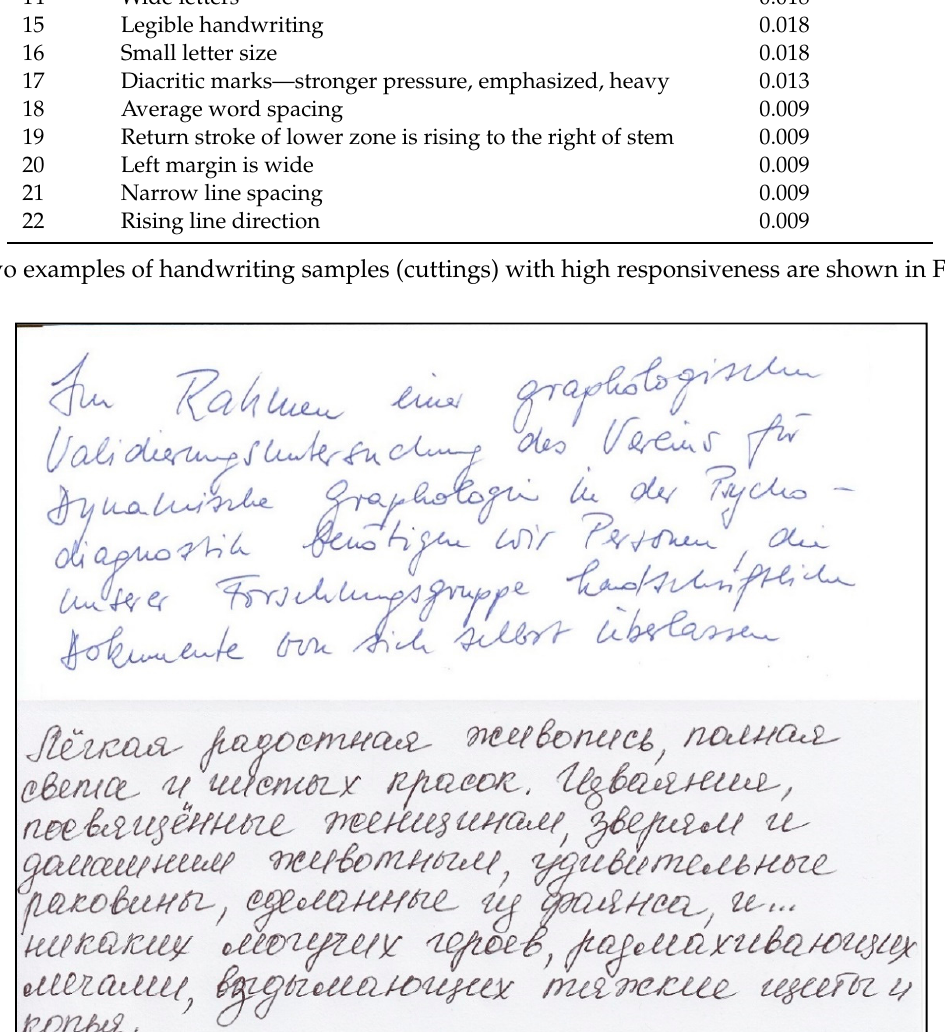
Table 1. Handwriting signs for trait “responsiveness”.